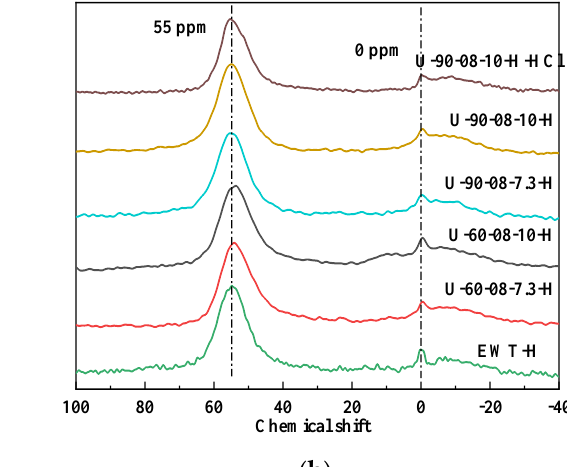
Figure 10. The Py-IR spectra of samples.